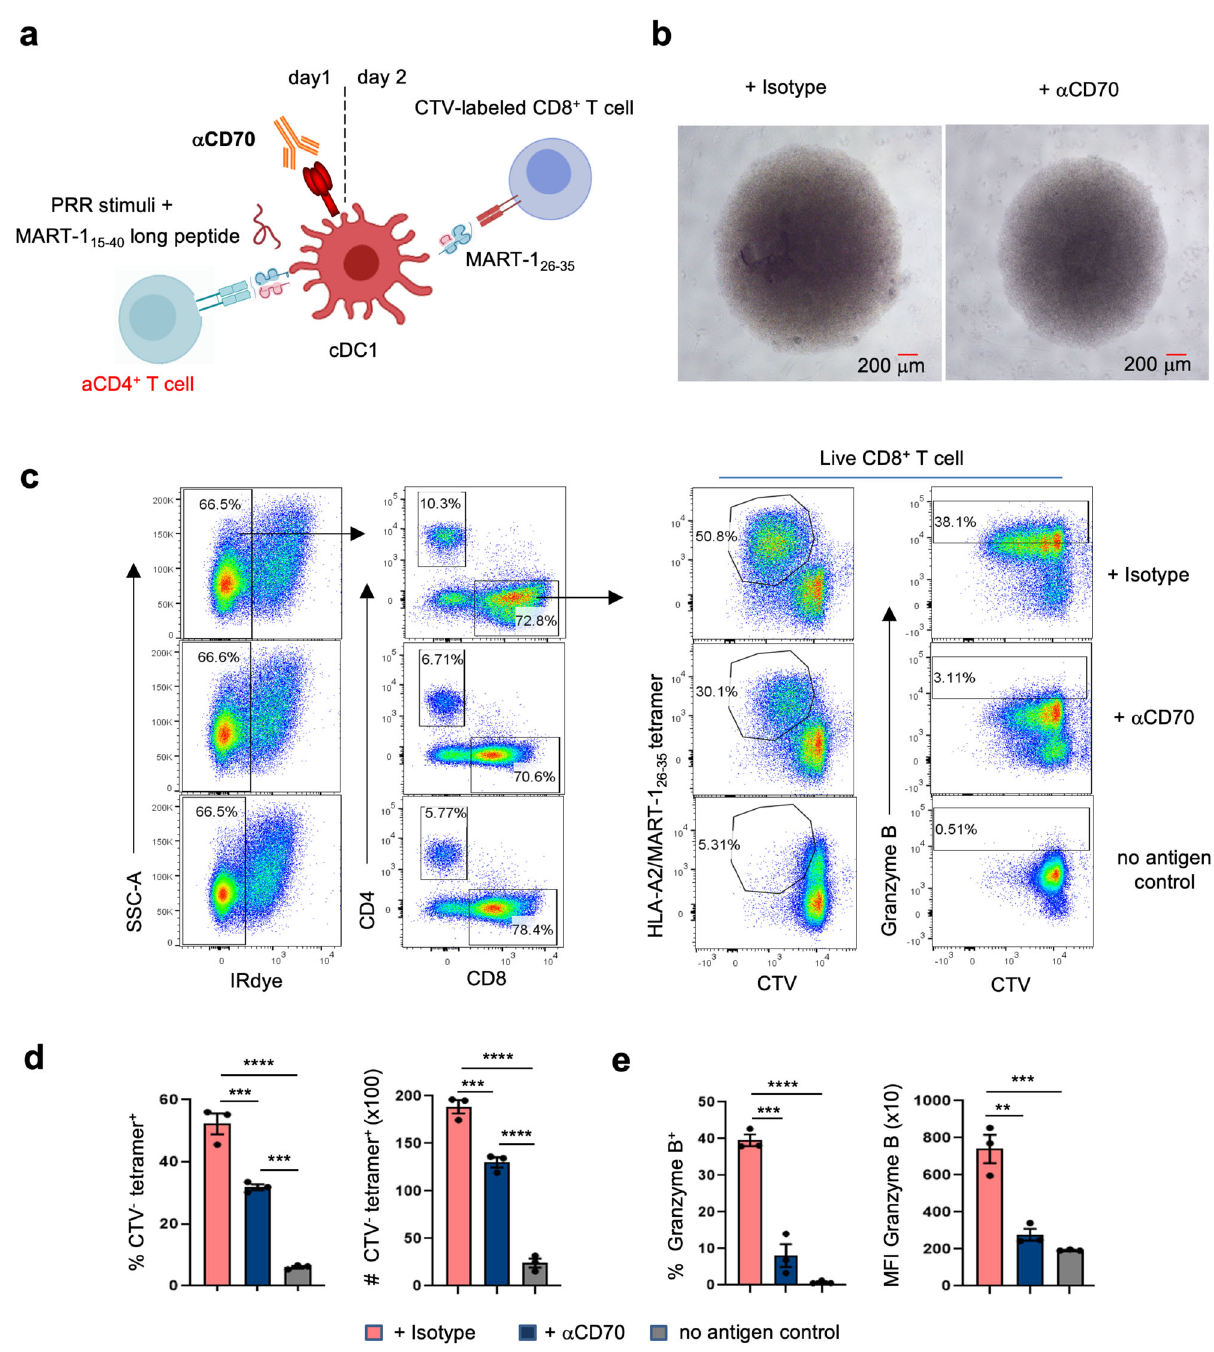
Fig. 3 | CD70 on human cDC1 promotes the CTL response to CD4 + T-cell help. Sorted cDC1 were incubated with CD70 blocking antibody (CLB-2F2 54 ) or isotype priming system in the presence of CD70 blockade. b Light microscopic images depicting CTL priming system at day 7 under indicated conditions. Images are representative of three independent experiments. c Flow cytometry plots depicting MART-1-speci fi c CD8 + T-cell proliferation based on CTV dilution and CTL